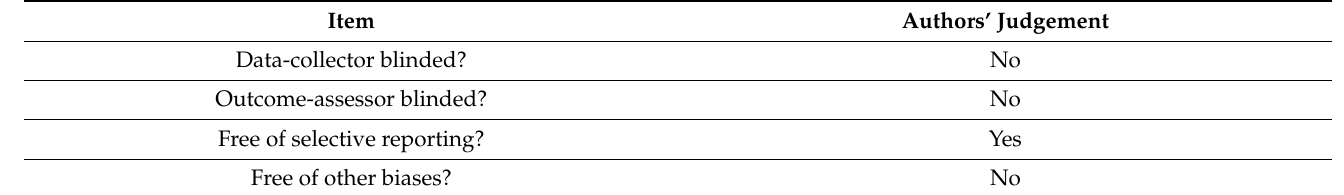
Table A18. Risk of